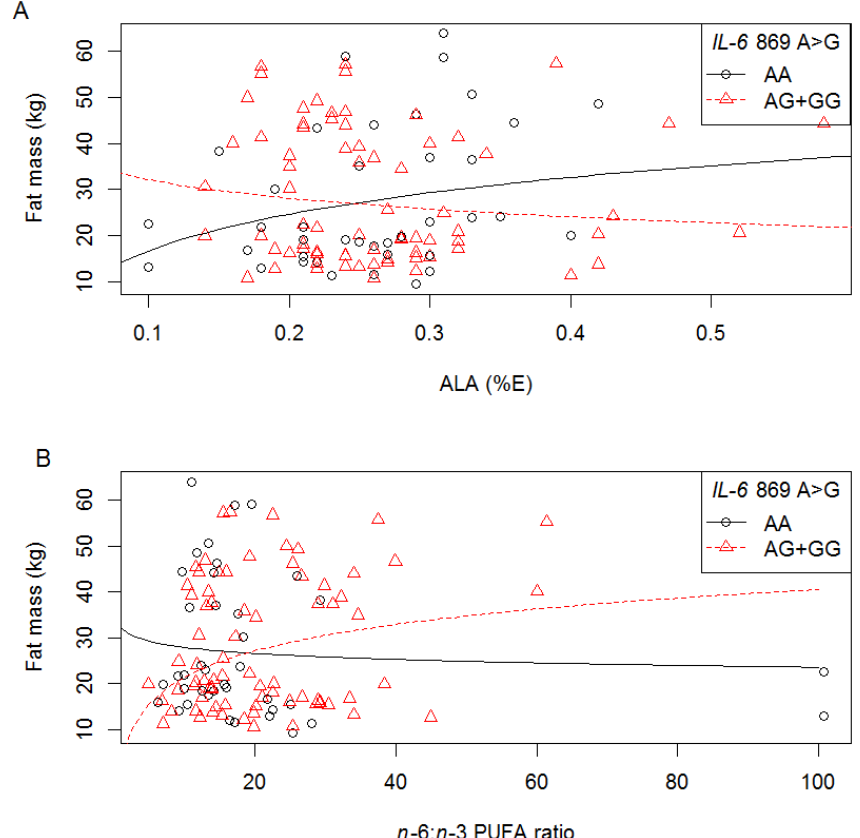
Figure 6. The relationship between fat mass, IL-6 IVS4 +869 A>G polymorphism and dietary fat intake in white women. Symbols represent, for each woman, observed values. The lines are modeled relationships for a woman of average age (27.3 years). ( A ) With increasing ALA intake (%E), fat mass decreased in those with the IVS4 +869 AG or GG genotype ( R 2 = 0.13, p = 0.048); ( B ) With increasing n -6: n -3 PUFA ratio, fat mass increased in those with the IVS4 +869 AG or GG genotype; compared to those with the AA genotype ( R 2 = 0.15, p =